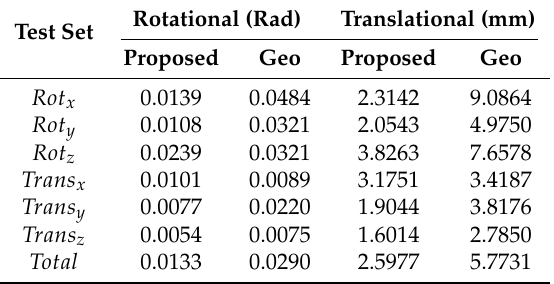
Table 2. Root mean square (RMS) errors in the test data.